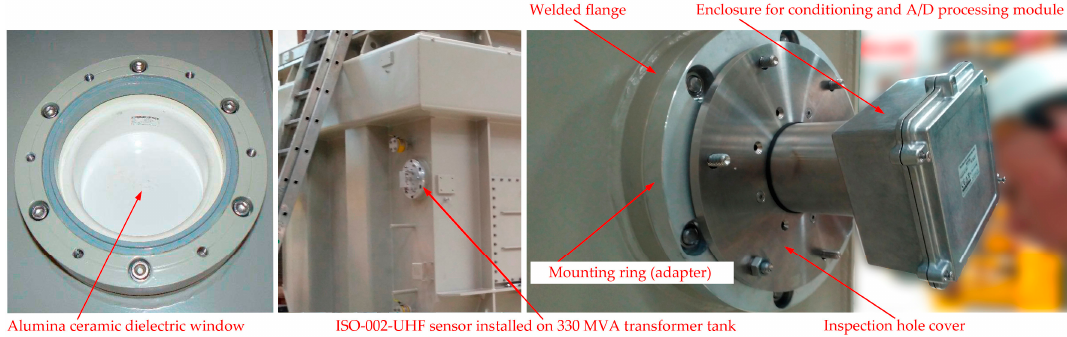
Figure 26. The installation of the UHF antenna (ISO-002-UHF sensor) in the dielectric window of the 330 MVA power transformer.